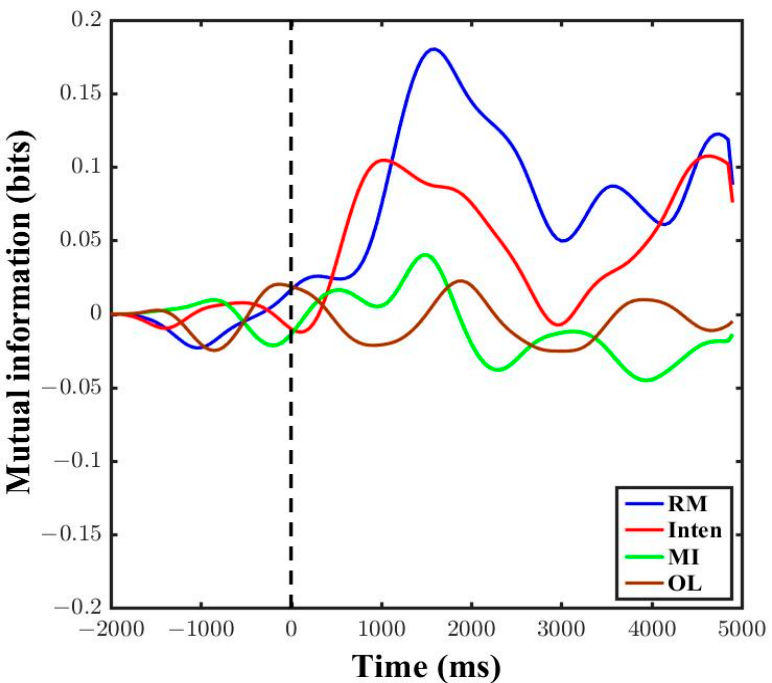
Figure 8. Comparison of mutual information in time series of data from one subject across all motor task conditions. The black vertical dotted line represents the point at which the participant was given the motor task instructions.